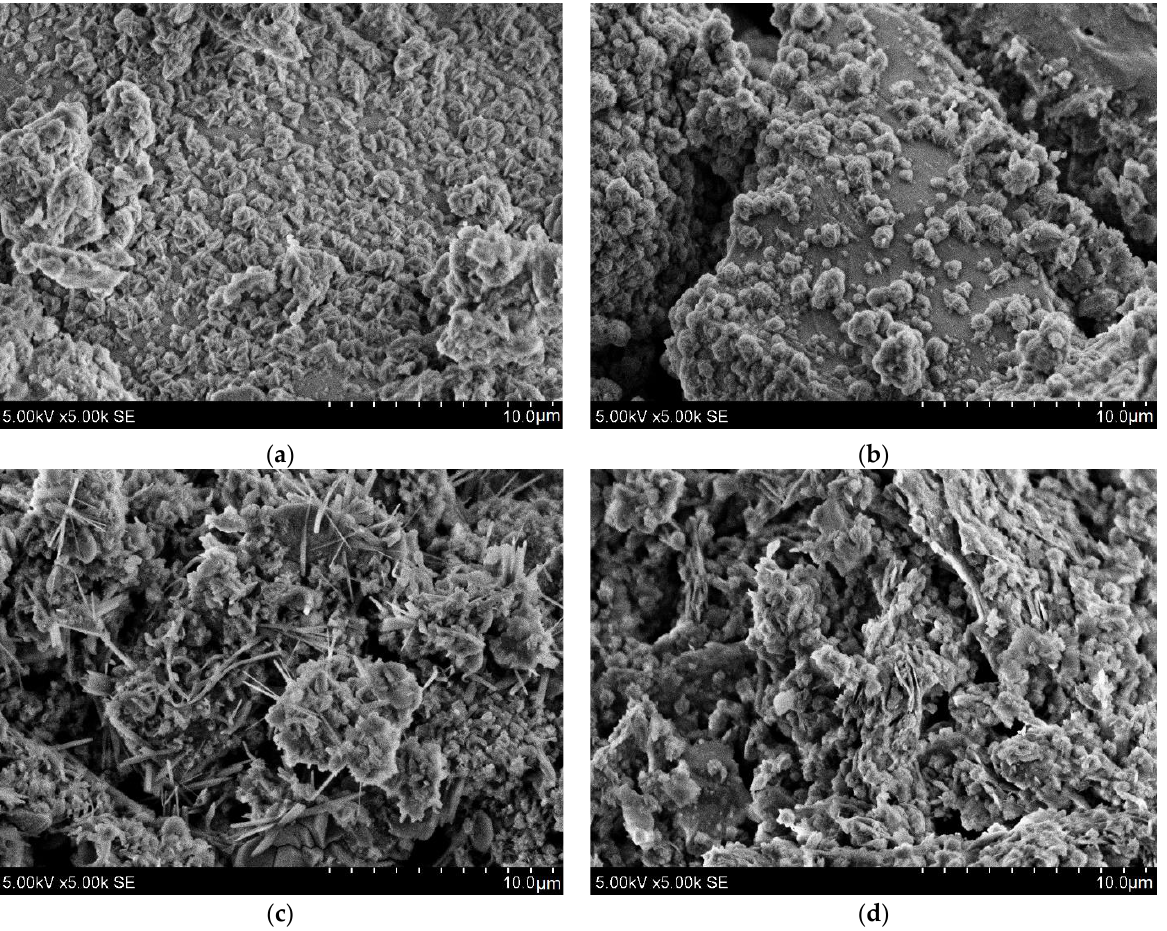
Figure 5. SEM images of AAM prepared from different precursors: ( a ) Br3x; ( b ) B95/5_Br3x; ( c ) B50C50; ( d ) C700.